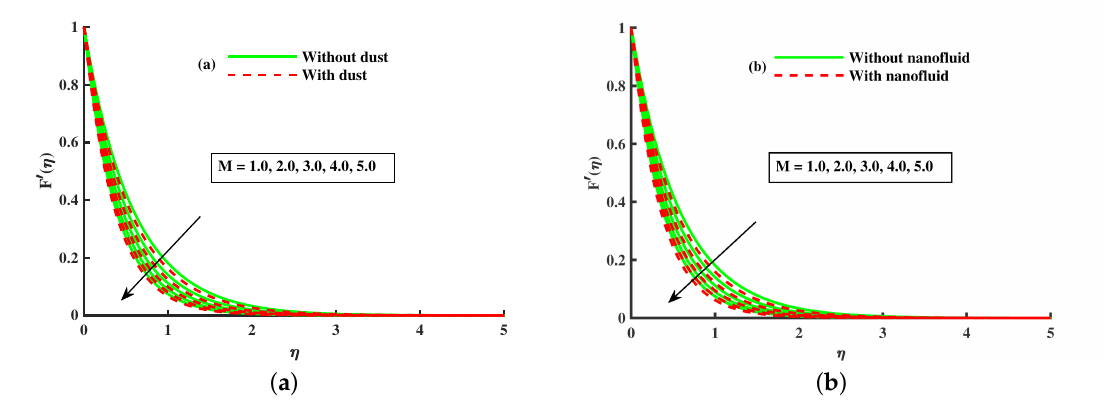
Figure 18. Fluctuation of M on F (cid:48) ( η ) ( a ) and effect of M on F (cid:48) ( η ) ( b ).